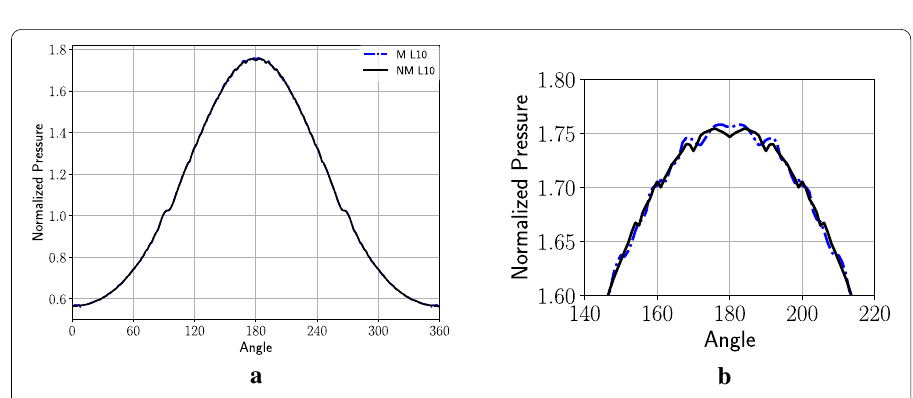
a b Fig. 13 Comparison: Moving (M) and non-moving (NM) cylinder for mesh refinement levels L10 over the angle. a Surface pressure of the cylinder geometry over the angle. b Zoom-in of the stagnation area